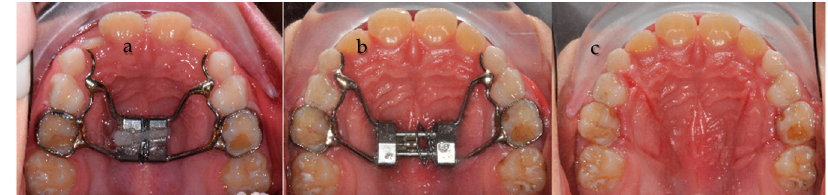
Figure 1. Test Group: Leaf Expander banded on primary second molars with an anterior arm till the canine before ( a ), after activation ( b ) and to the removal ( c ).